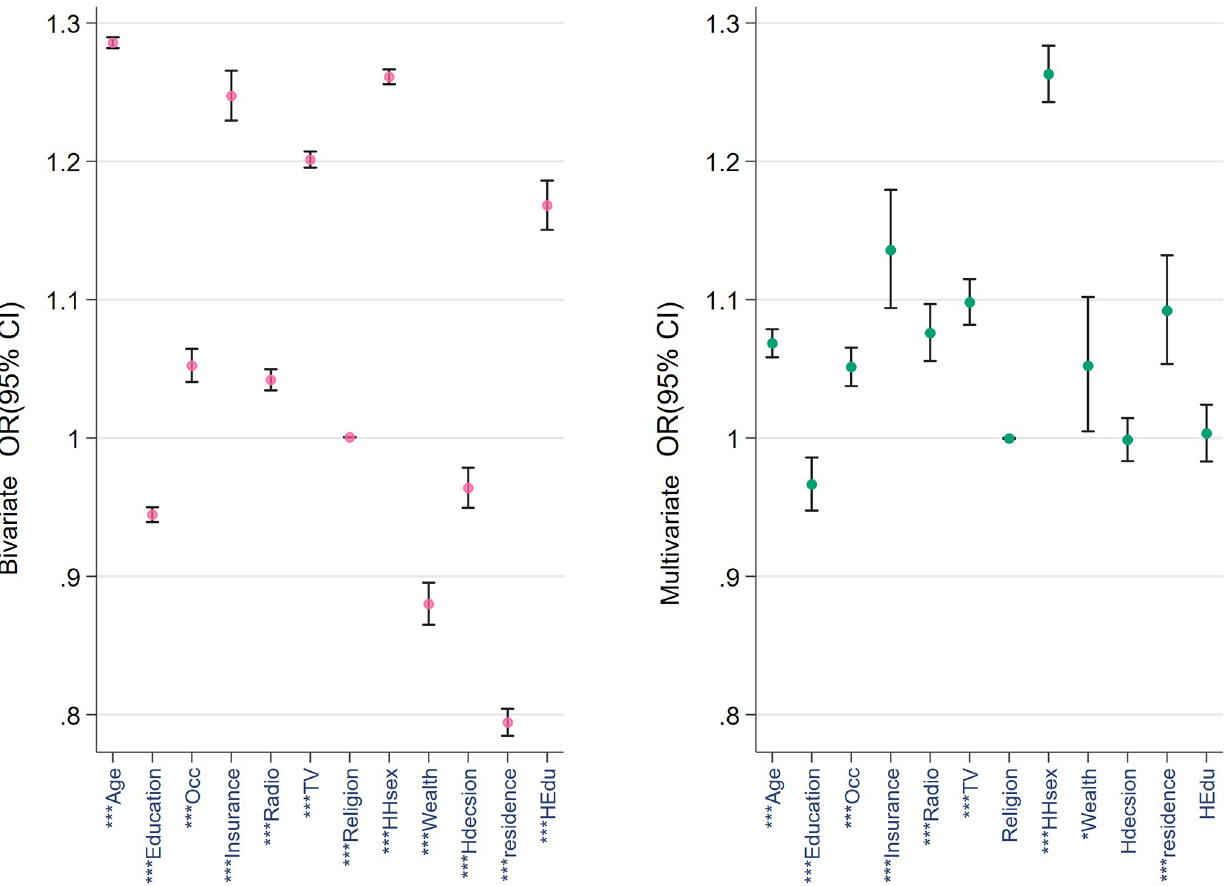
Fig 1. Bivariable and multivariable correlation among cervix test and the covariables. N.B.: � p < 0.05, �� p < 0.01, ��� p < 0.001. HHsex = household head’s sex; Hdecision = healthcare decision maker, HEdu = husband’s education.